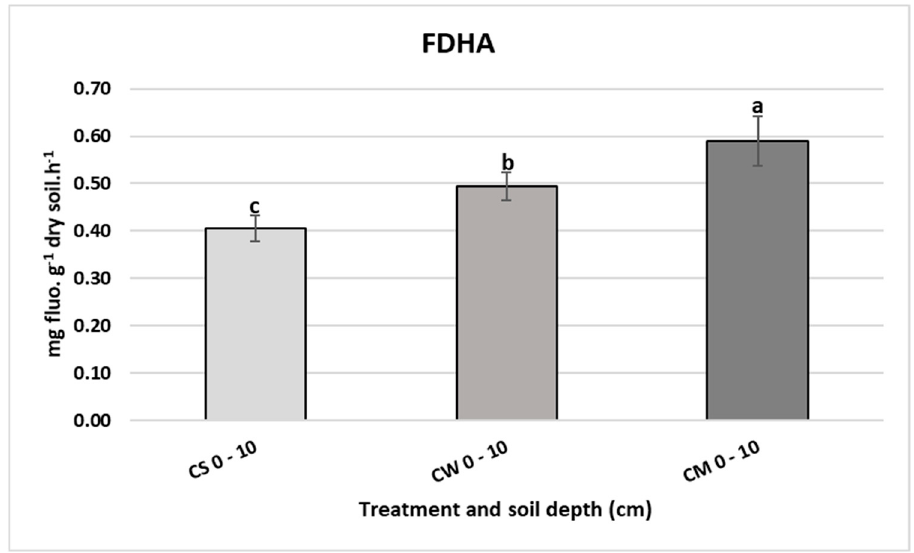
Figure 5. Fluorescein diacetate hydrolytic activity (mg fluo.g − 1 dry soil.h − 1 ) in unplanted soil (CS), soil cultivated by wheat (CW) and soil cultivated by miscanthus (CM) at 0–10 cm depths. Values are presented as means ± SD. Different letters refer to significant differences in soils (Fisher LSD test, n = 4, p ≤ 0.05).